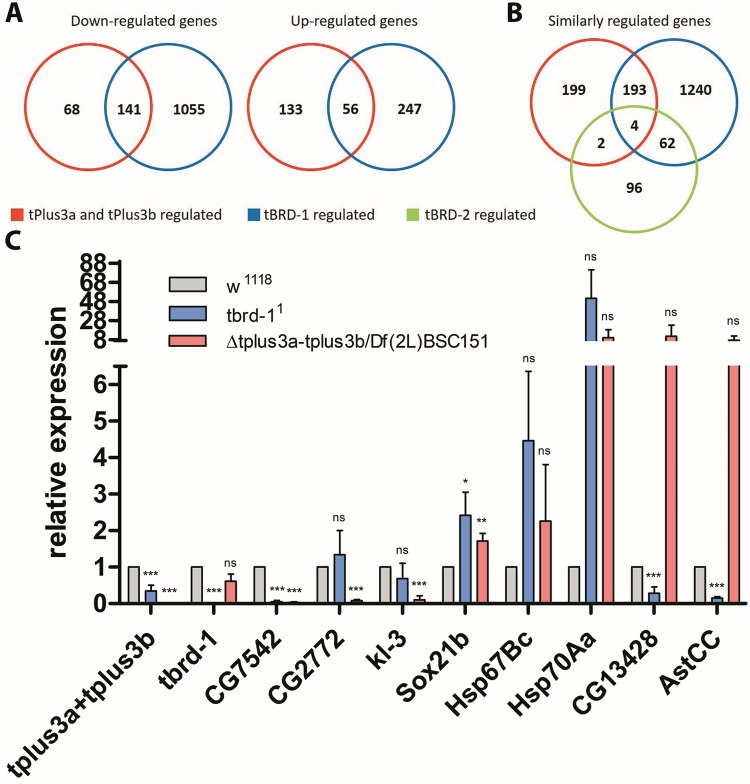
tPlus3a and tPlus3b and tBRD-1 regulate a common set of genes.Transcript expression was measured with RNA-seq in three replicates each of testes RNA of the wild-type, Δtplus3a-tplus3b/Df(2L)BSC151, and tbrd-11 mutants. Expression levels in mutants are relative to those in the wild-type, which were set to 1. Differentially expressed genes were identified using a log2 FC ≥ 1 and ≤ −1. (A-C) Numbers indicate the number of genes that were shown to be regulated (A) Venn diagrams showing the overlap between down-regulated and up-regulated genes in Δtplus3a-tplus3b/Df(2L)BSC151 (tPlus3a and tPlus3b regulated) and tbrd-11 (tBRD-1 regulated) mutants relative to the wild-type. (B) Venn diagram showing the overlap of similarly regulated genes in Δtplus3a-tplus3b/Df(2L)BSC151, tbrd-11, and tbrd-2 knock-down testes (tBRD-2 regulated). (C) Validation of RNA-seq results using qPCR, normalized to Rpl32. As controls, no tplus3a-tplus3b and tbrd-1 transcripts were expressed in the respective mutants. P-values for significance Δtplus3a-tplus3b/Df(2L)BSC151 or tbrd-11 compared to wild-type: * p < 0.025, ** p < 0.005 and *** p < 0.0025.